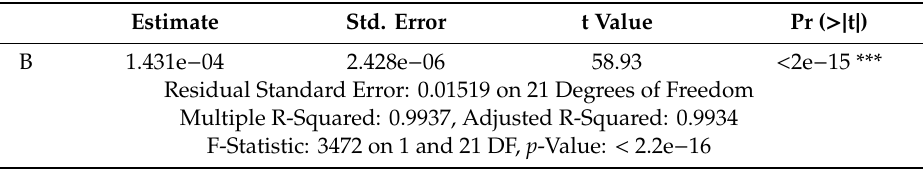
Table 12. Statistical parameters for the power regression model Y = b · X3 1.366 .